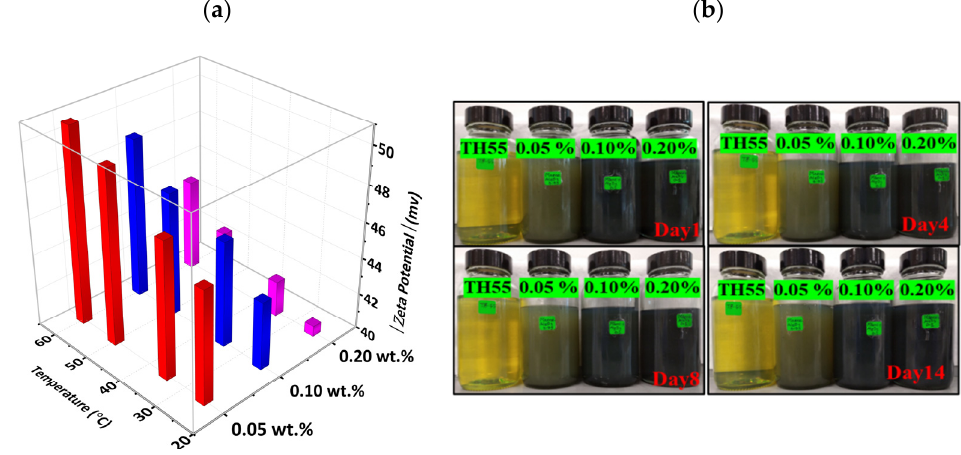
Figure 3. ( a ) Zeta potential of TH55/MXene + Al 2 O 3 at different temperatures and concentrations, ( b ) digital photographs of formulated nanofluids from day 1 to day 14.